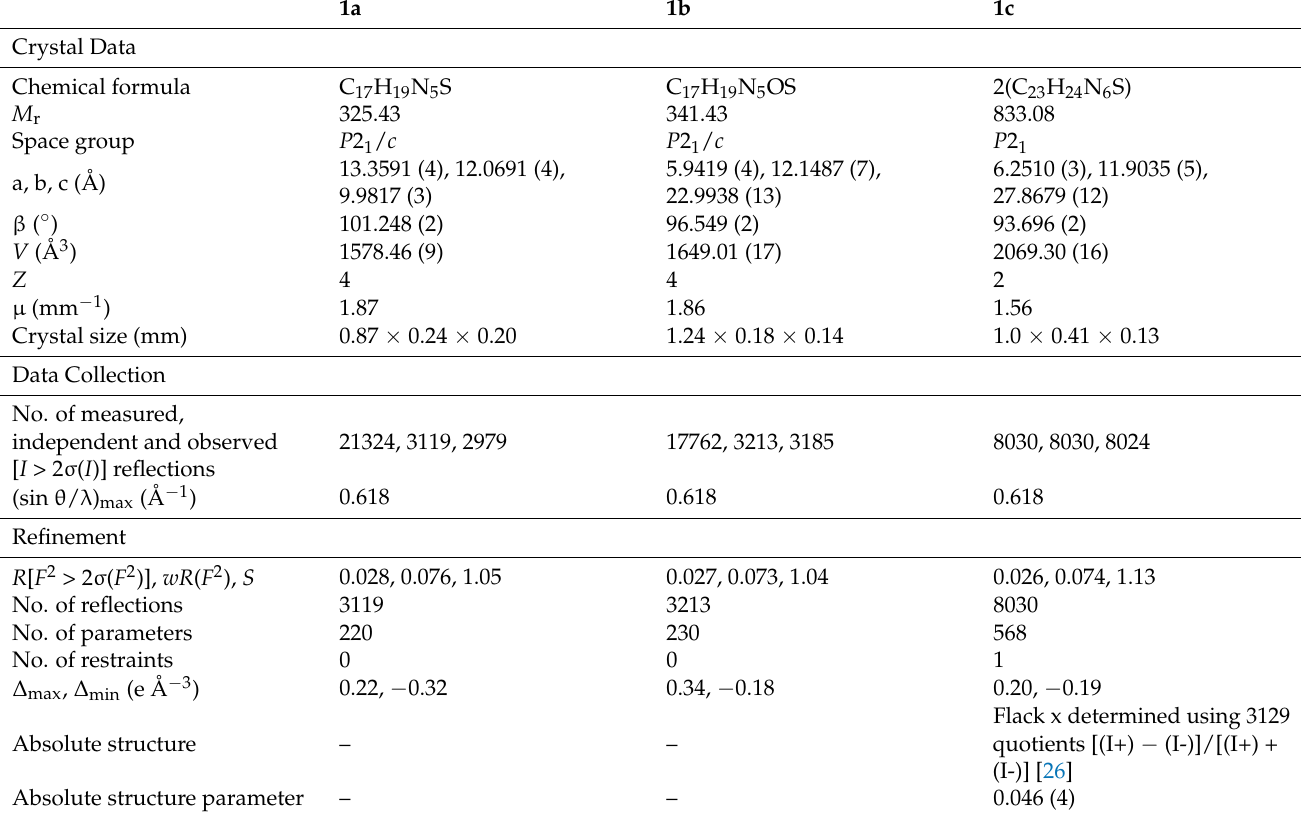
Table 1. Crystal data, data collection, and refinement details.